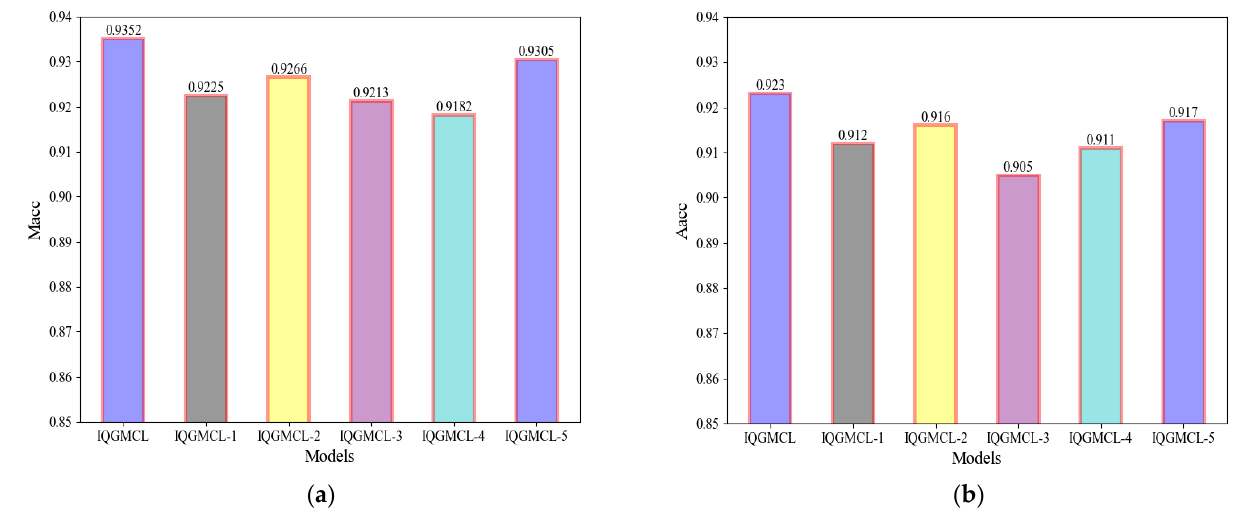
Figure 6. Various network experiments Macc and Aacc. ( a ) Macc; ( b ) Aacc.